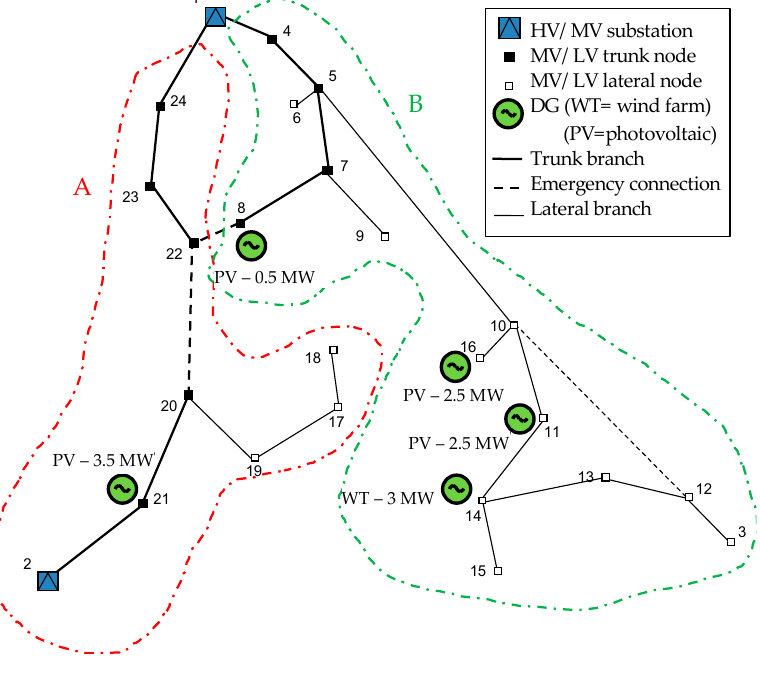
Figure 6. Test network.